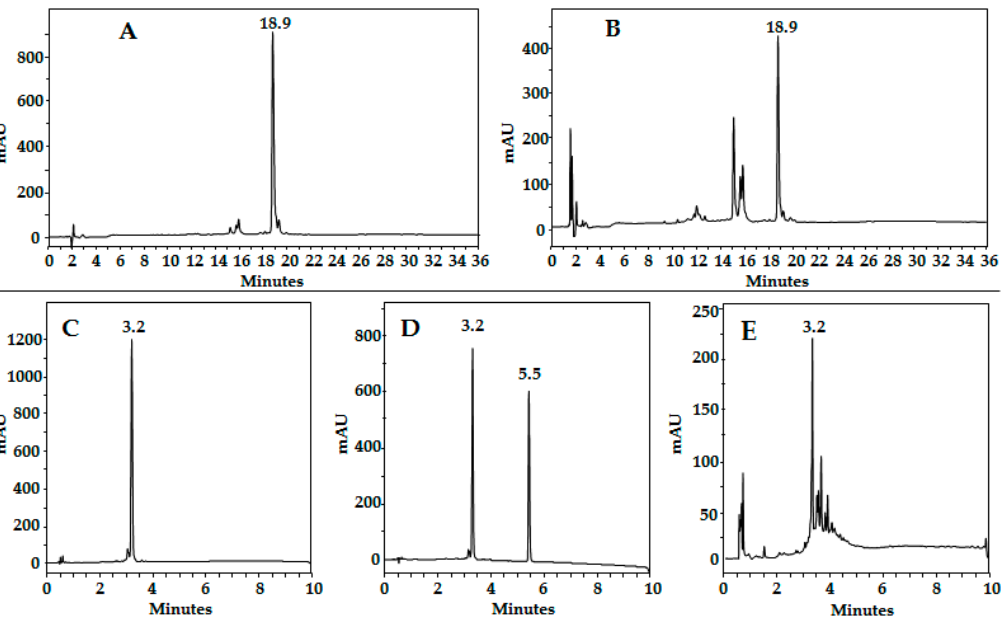
Figure 2. Stability of peptides derived from SPINNTKPHEAR. Chromatographic profile of peptide HPV-1 (( A ), t R : 18.9 min); ( B ) HPV-1 mixed with cysteine solution and lyofilized; ( C ) peptide HPV-5